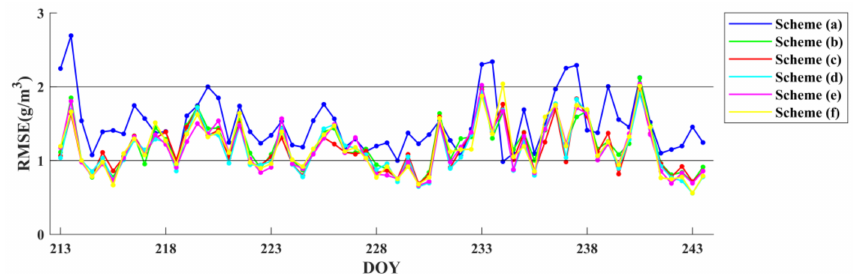
Figure 7. Time series of the RMSE of the tomographic reconstructions derived from the six schemes using radiosonde data as a reference for 31 days (DOY 213 to DOY